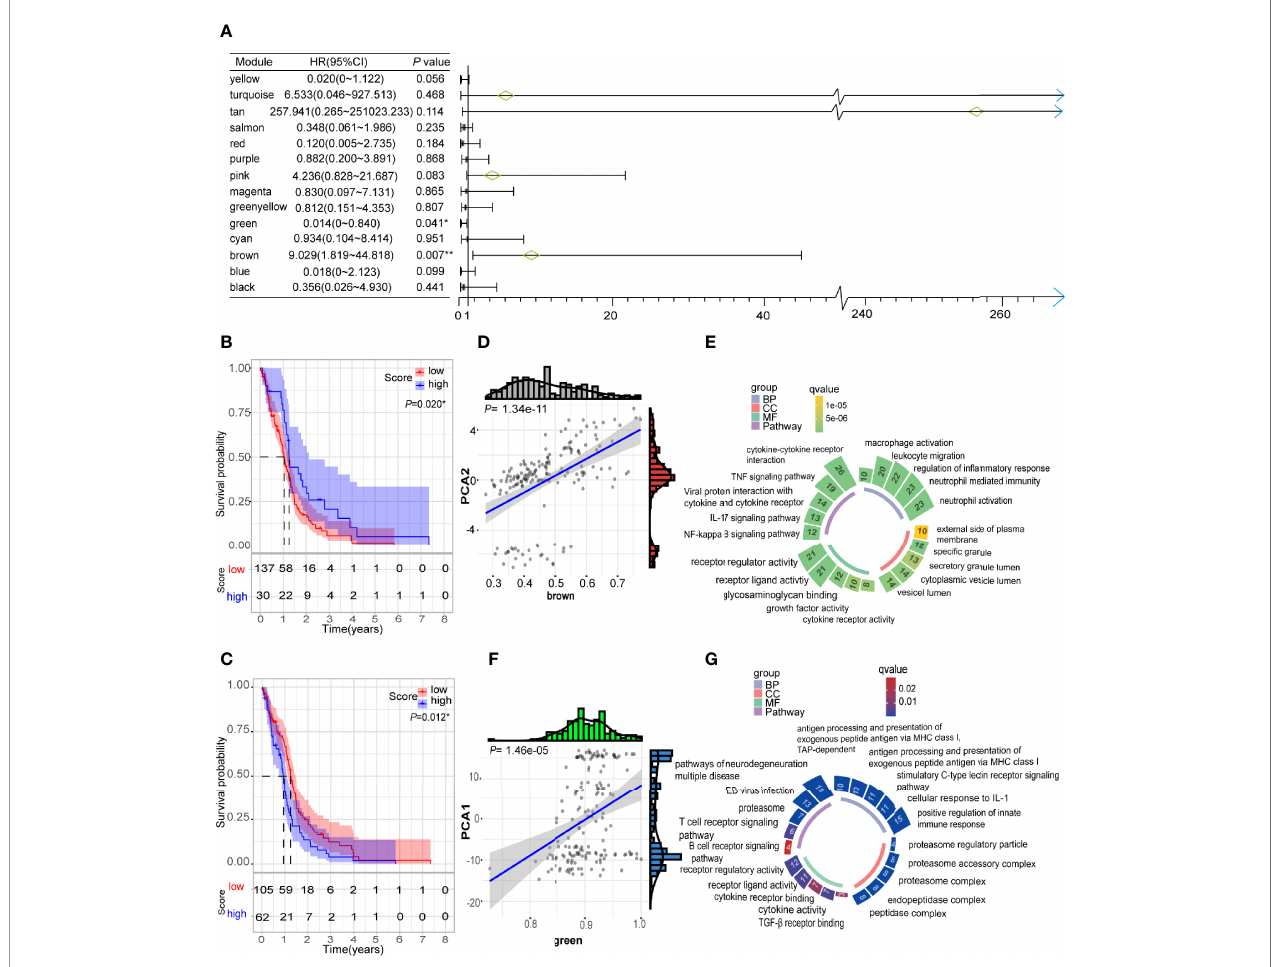
FIGURE 9 | Identi fi cation of immune hub genes of GBM. (A) Forest maps of single factor survival analysis of 14 modules of GBM. (B) Differential prognosis in brown module with high and low mean. (C) Differential prognosis in green module with high and low mean. (D) Correlation between brown module feature vector and second principal component in immune landscape. (E) Circular barplot showing GO term (BP: biology process; CC: cellular component; MF: molecular function) and KEGG term (pathway) in the brown module. The barplot size and color intensity represent the gene count and enrichment level respectively. (F) Correlation between green module feature vector and fi rst principal component in immune landscape. (G) Circular barplot showing GO term (BP, biology process; CC, cellular component; MF, molecular function) and KEGG term (pathway) in the green module. The barplot size and color intensity represent the gene count and enrichment level respectively. * p <